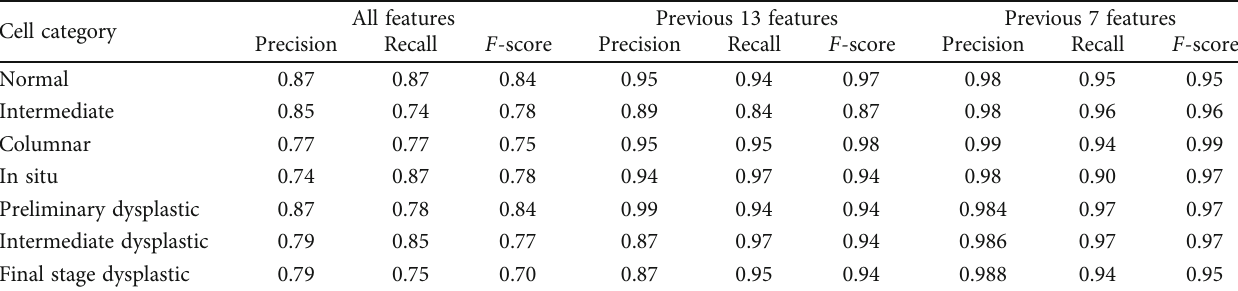
Table 3: Impact of classi fi cation accuracy using previous feature selection versus all features on di ff erent cervical cells.